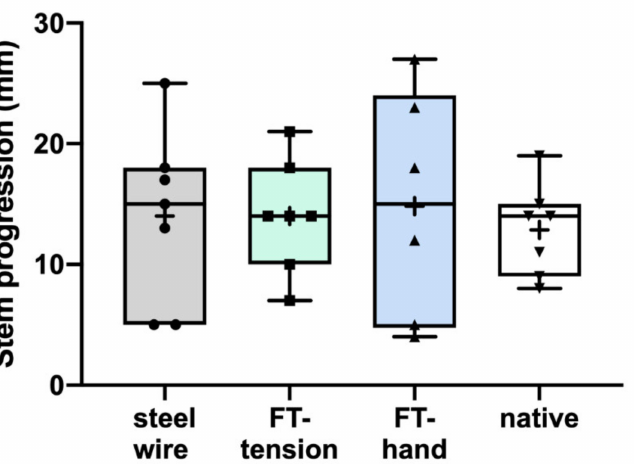
Figure 6. Stem progression measured before the start of the biomechanical testing to the appearance of a fracture did not differ between groups.